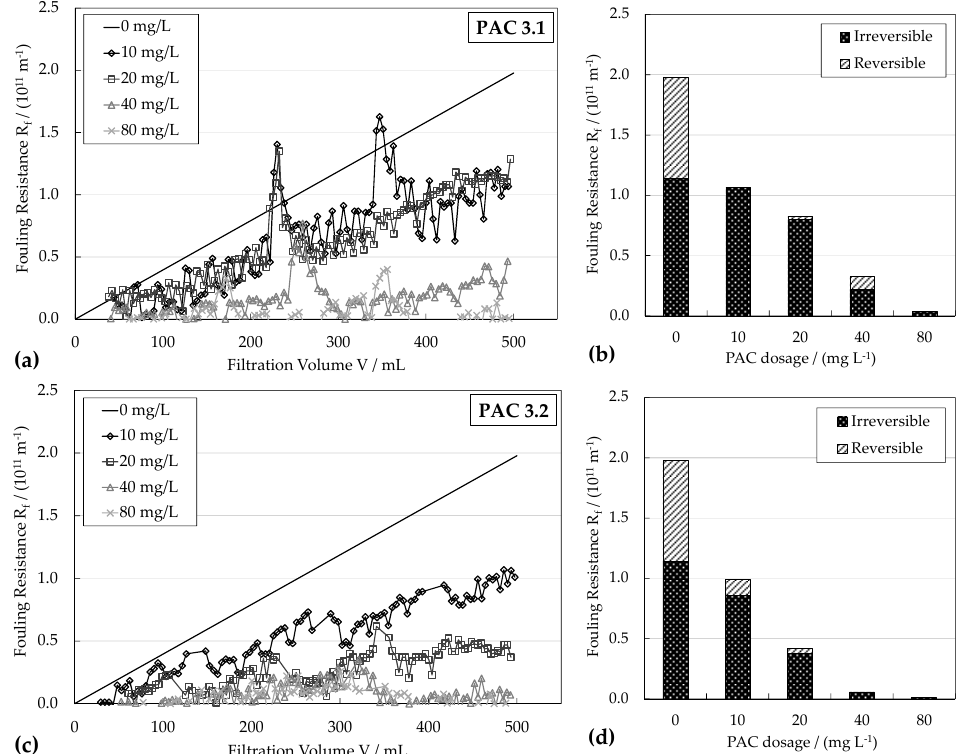
Figure 7. Ultrafiltration with pre-deposition of milled PACs in varying concentrations. Left: Fouling resistance development during filtration of raw water with pre-deposition of ( a ) PAC 3.1 and ( c ) PAC 3.2. Right: Average hydraulic reversible and irreversible resistance after filtration of raw water with pre-deposition of ( b ) PAC 3.1 and ( d ) PAC 3.2. (Membrane: 150 kDa; PES; 2.87 × 10 − 3 m 2 ; V F = 500 mL; n = 2–3).